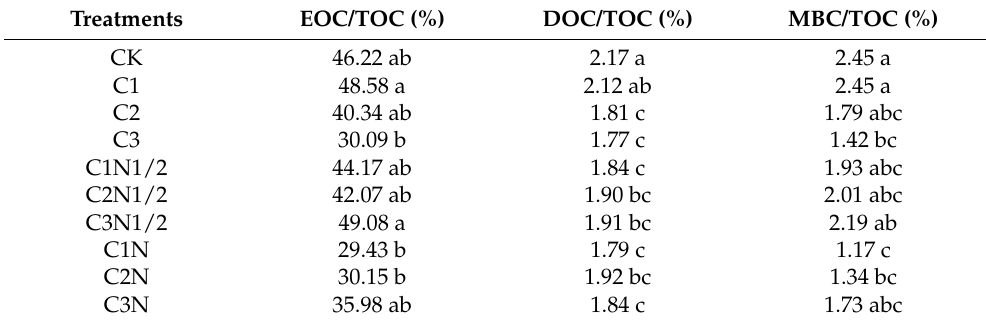
Table 3. The ratio of activated organic carbon fraction to TOC under different treatments. Treatments